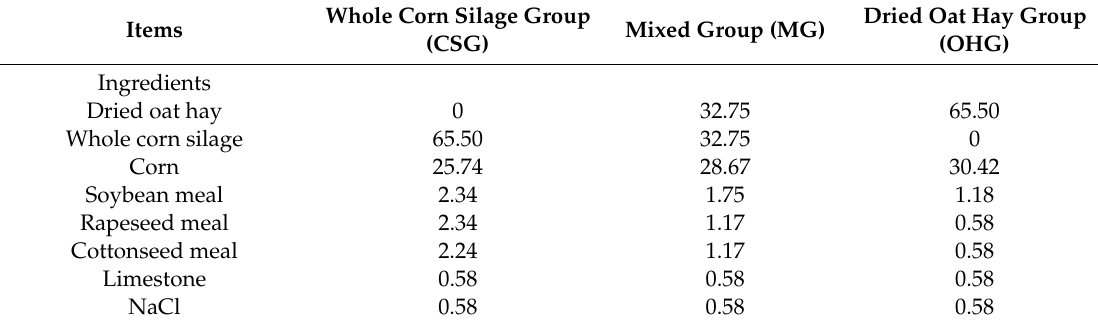
Table 2. Composition and nutrient levels of experimental diets (dry matter (DM) basis)